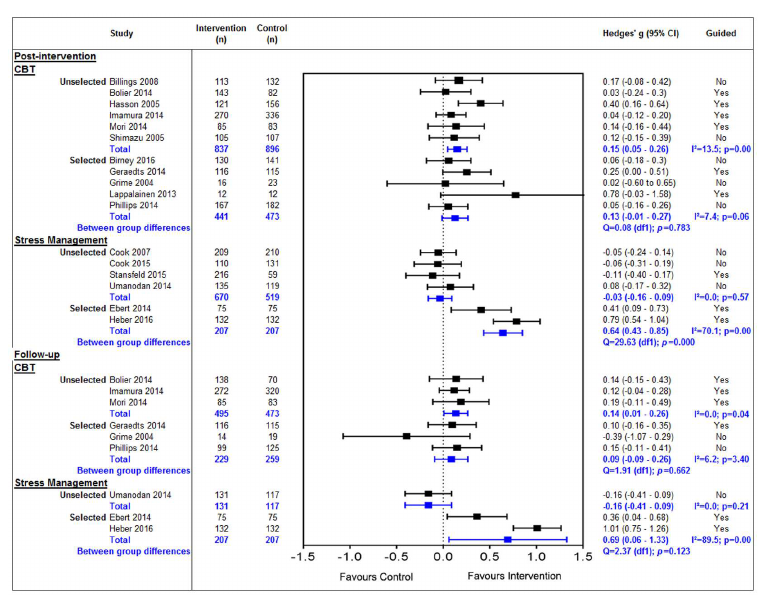
Fig 3. Sub-group analysis of the effect of eHealth interventions in the